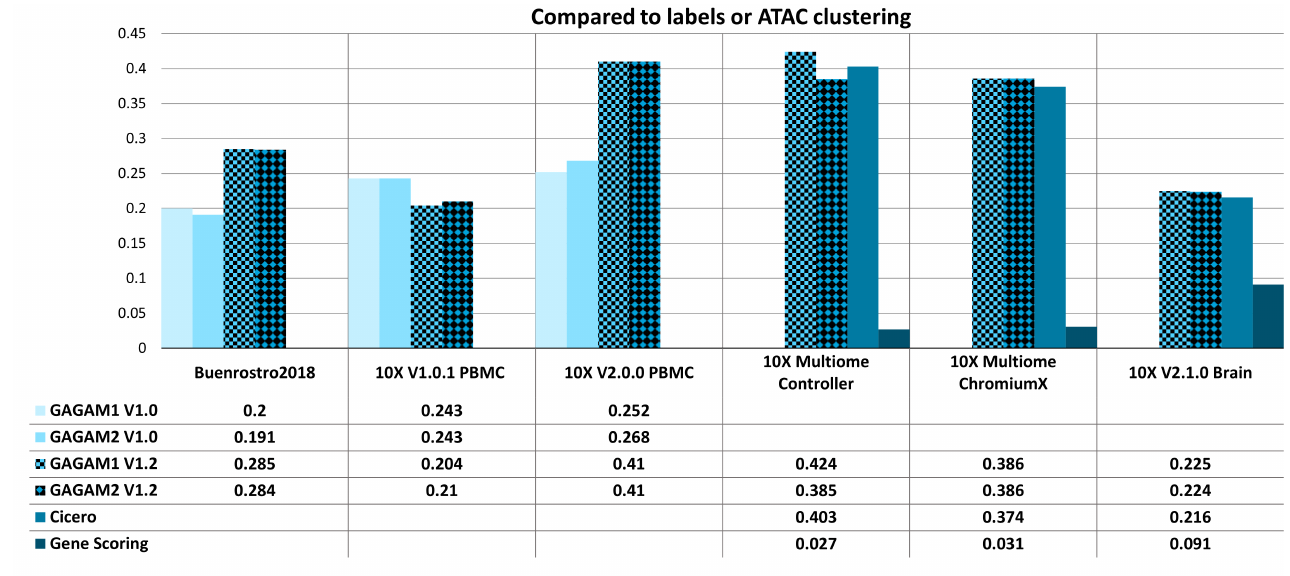
Figure 8. RAGI results of both Old ( left ) and New ( right ) datasets when compared to labels or ATAC clustering. The Old datasets are compared with the previous GAGAM v1.0 from [10], while the New datasets are with Cicero and